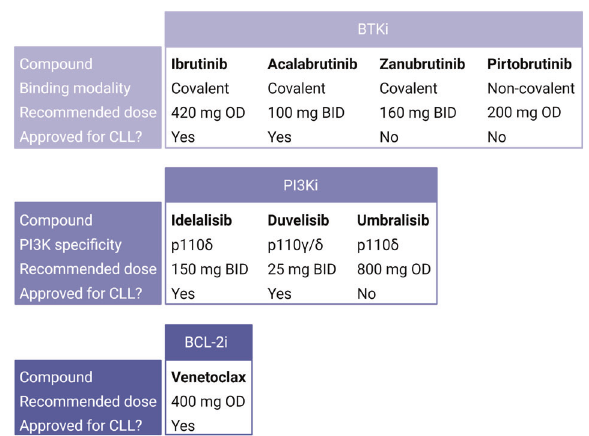
Fig. 2 Approved and select investigational targeted therapies in CLL. BCL-2i B-cell lymphoma-2 inhibitor, BID bis in die (twice a day), BTKi Bruton ’ s tyrosine kinase inhibitor, CLL chronic lymphocytic leukemia, PI3Ki phosphatidylinositol 3-kinase inhibitor, OD omne in die (once